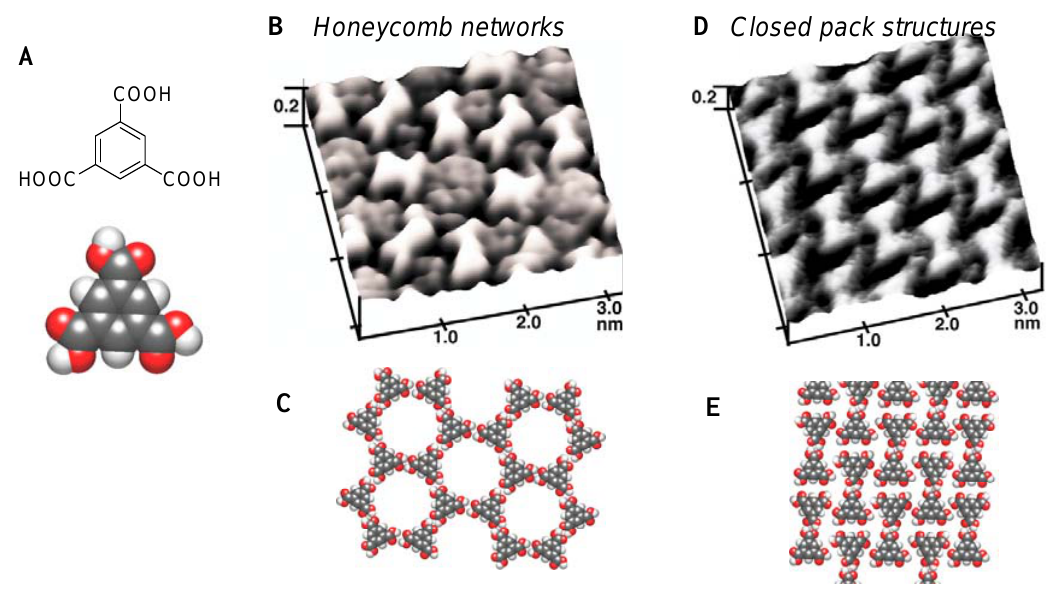
Figure 7. Chemical structure (A), STM images (B and D) and schematic illustrations (C and E) of TMA order-order transitions at the aqueous solution–Au(111) interface under the electrochemical control. Reproduced from reference [33] by permission of The Royal Society of